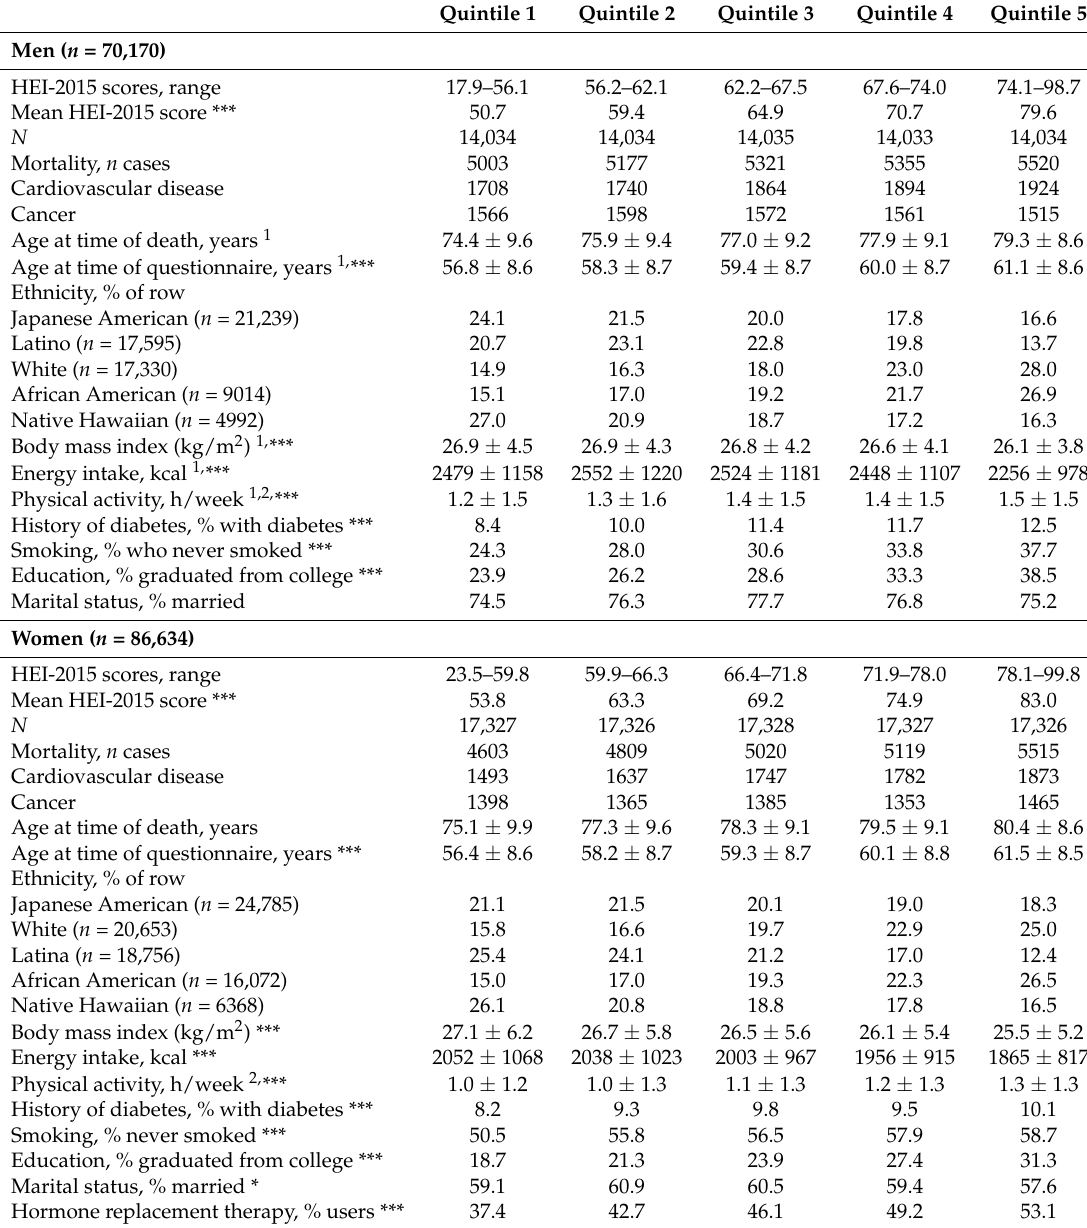
Table 2. Descriptive characteristics of participants ( n = 156,804) in the Multiethnic Cohort by quintiles of Healthy Eating Index-2015 (HEI-2015)